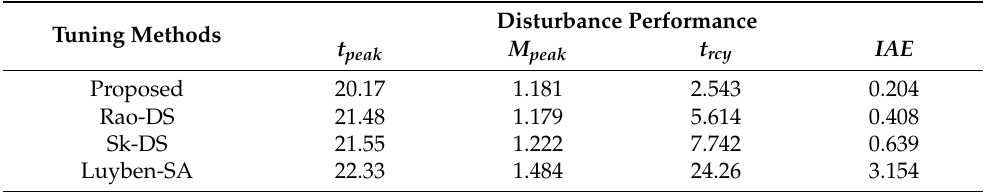
Table 8. Quantitative comparison of responses to disturbance in IFOPTD with − 10% parameter